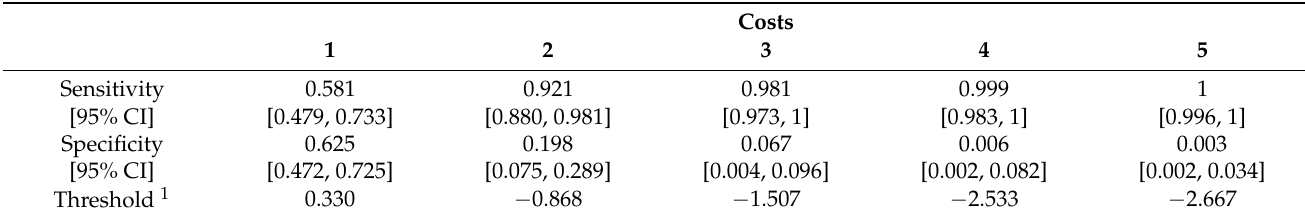
Table 3. Prognostic value of PD-PRS.